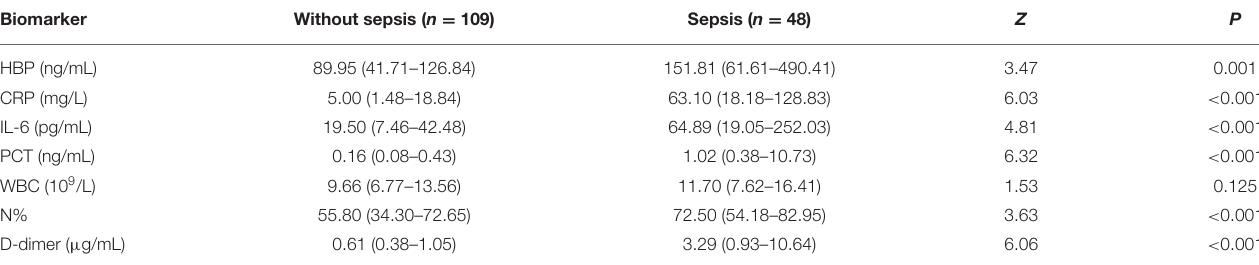
TABLE 3 | Biomarkers in children with or without sepsis.